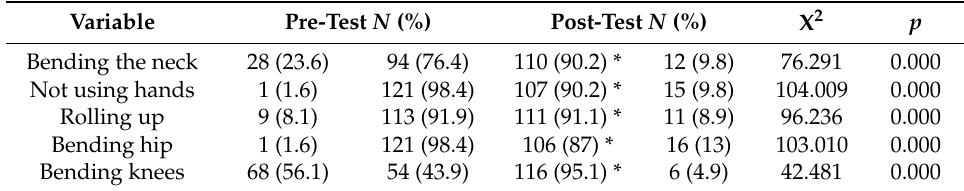
Table 1. Statistics of assimilation of trained responses in falls backwards.